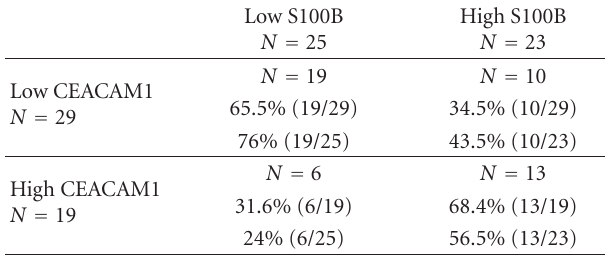
Figure 1: sCEACAM1 in WED patients increases over time and as compared with NED patients. sCEACAM1 was measured by ELISA in serum samples of 29 NED (A, B) and 20 WED (C,D) malignant melanoma patients, both before (time point 0) and following treatment (time point 1). Vertical lines indicate